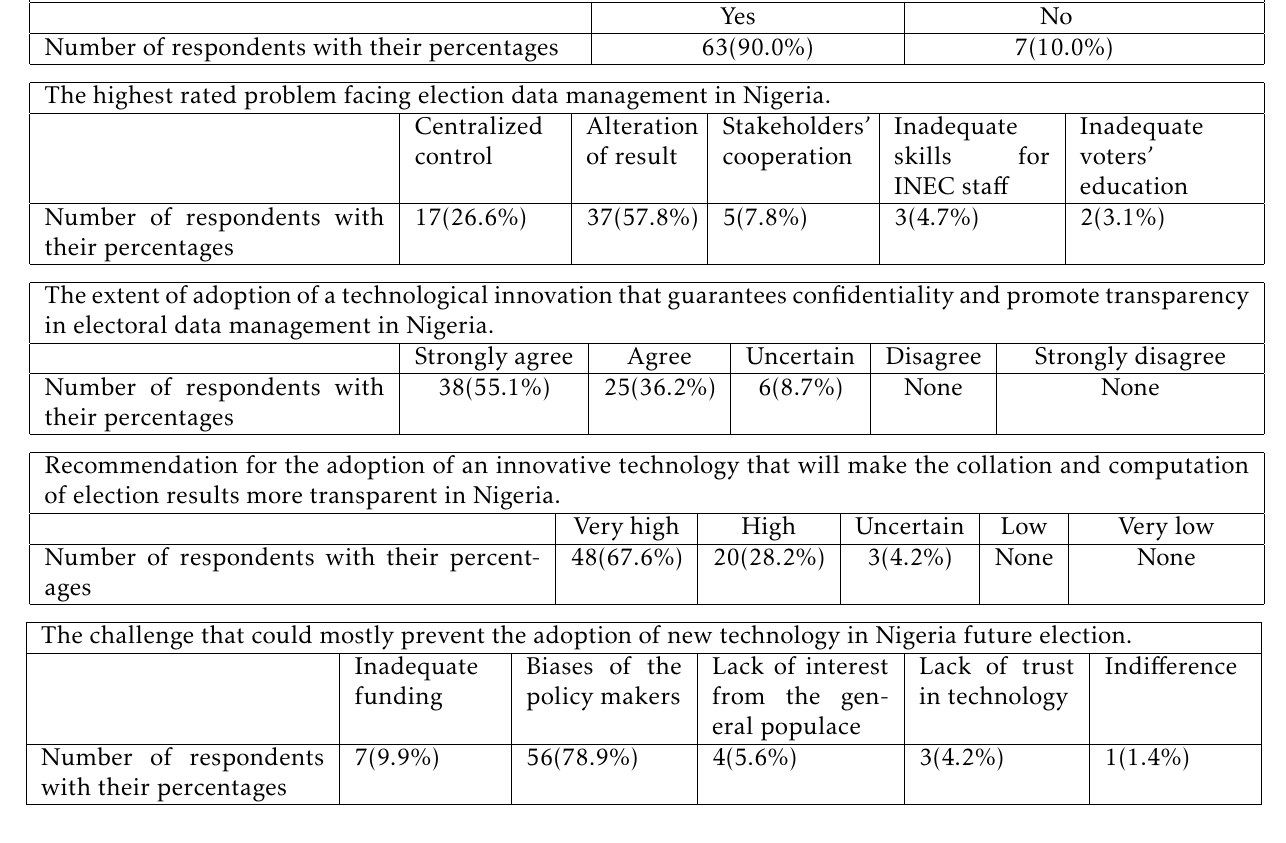
Table 4. Participants’ opinion related to the problems of existing voting technology/election data management. There is problems facing the way electoral data are being managed in Nigeria. Number of respondents with their